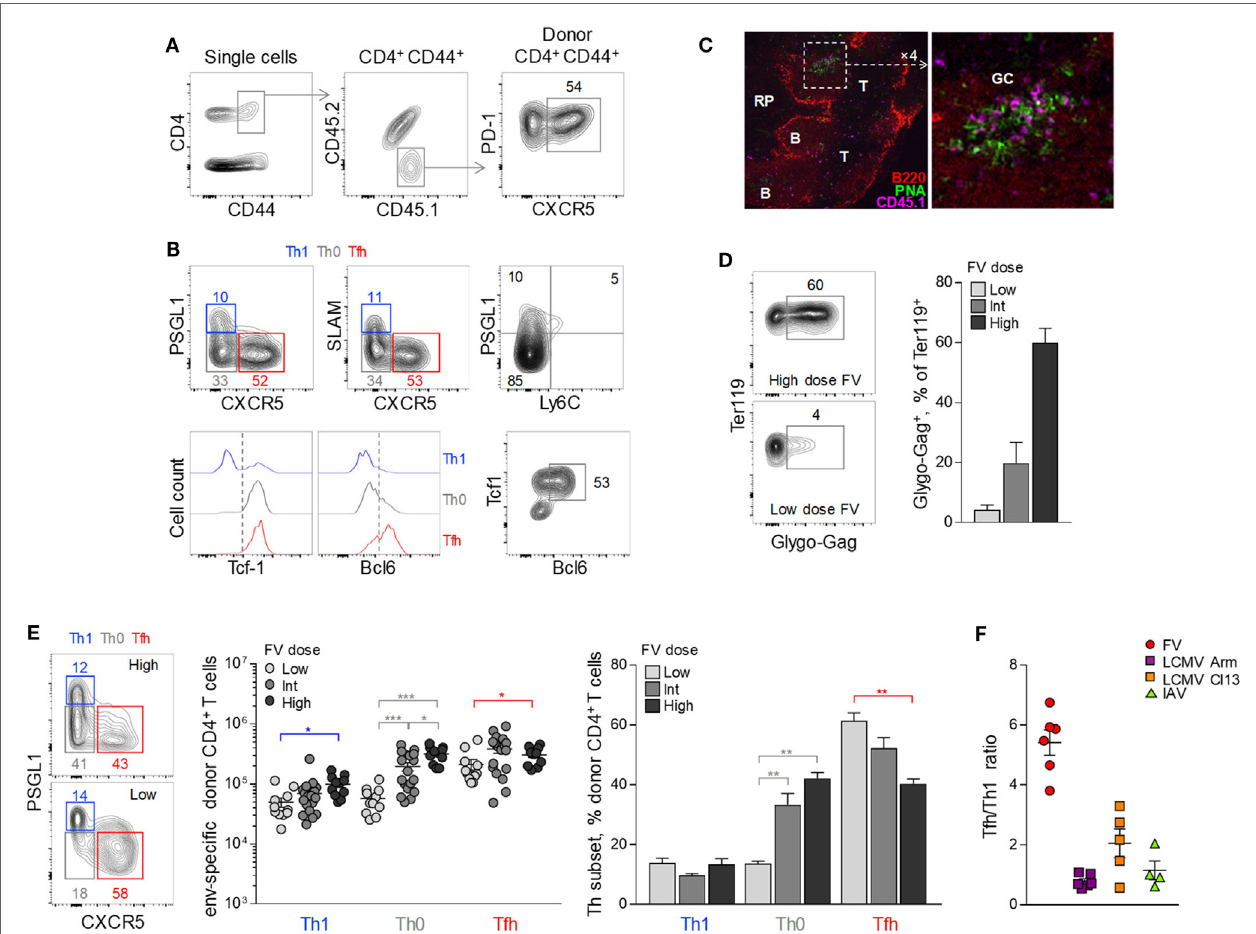
FigUre 1 | Follicular helper (Tfh) cells heavily dominate the CD4 + T cell response to F-MLV env. (a,B) CD4 + TCR β -transgenic EF4.1 T cells were adoptively transferred into CD45.1 + CD45.2 + WT recipients infected with an intermediate dose of Friend virus (FV) (1,000 spleen focus-forming units) and analyzed by flow cytometry in the spleen 7 days later. (a) Gating strategy for the identification of env-reactive (CD4 + CD44 + ) and Tfh-phenotype (PD-1 + CXCR5 + ) donor cells in these recipients. (B) Flow cytometric characterization of Th1 (in blue), Th0 (in gray), and Tfh (in red) subsets in env-reactive donor CD4 + CD44 + T cells. (c) CD45.1 + CD4 + EF4.1 T cells were adoptively transferred into FV-infected CD45.2 + WT recipients and detected by immunofluorescence microscopy in spleen sections 7 days later (RP, red pulp; B, B cell zone; T, T cell zone; GC, germinal center). Donor CD4 + were identified as CD45.1 + cells and germinal centers were visualized by staining with peanut agglutinin (PNA). (D) Flow cytometric example of FV-infected Glygo-Gag + Ter119 + cells ( left ) and frequency of Glygo-Gag + cells in the Ter119 + population ( right ) in the spleens of WT B6 mice infected with different doses of FV. Mean frequency ( ± SEM, n = 3 mice per group) of one representative of two experiments is shown. (e) Profile of PSGL1 and CXCR5 expression ( left ), absolute number ( middle ), and mean frequency ( ± SEM) ( right ) of Th1, Th0, and Tfh cells in env-reactive donor CD4 + T cells from the spleen of recipient mice infected with the indicated doses of FV (data are from 4–6 experiments for each FV dose with at least three mice per experiment). (F) Tfh/Th1 ratio in env-reactive donor CD4 + T cells after FV infection (individual symbols denote the mean Tfh/Th1 ratio in independent experiments with at least 3 mice per experiment), compared the Tfh/Th1 ratio reported in the literature for virus-specific CD4 + T cells responding to infection